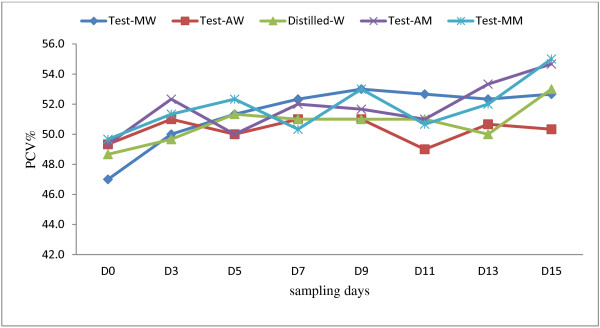
PCVs of uninfected mice during subacute toxicity testing. The uninfected mice were treated with either water and methanol extracts of A. absinthium and M. stenopetala or water only (MW = M. stenopetala in water, AW = A. absinthium in water, Distilled-W = water, AM- A. absinthium in methanol, MM- M. stenopetala in methanol).